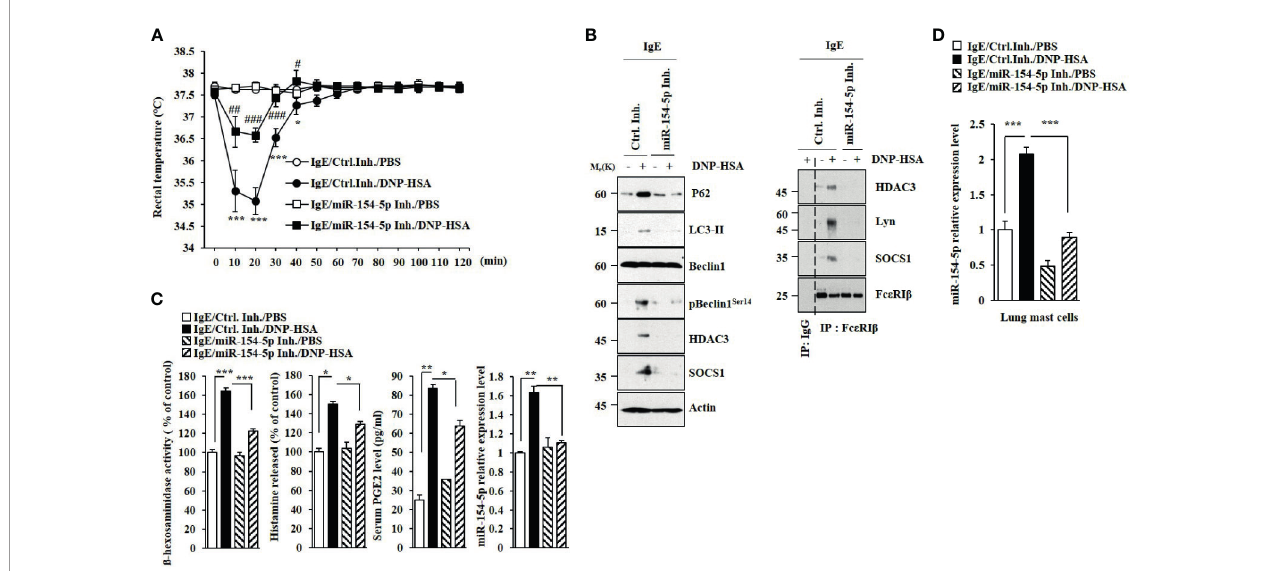
FIGURE 3 | MiR-154-5p mediates PSA. (A) BALB/C mice were intravenously injected with DNP-speci fi c IgE along with the indicated inhibitor (3.5 m g/kg). The following day, BALB/C mice were intravenously injected with DNP-HSA (250 m g/kg). Rectal temperatures were then measured. Each experimental group consisted of fi ve mice. Means ± S.E. of three independent experiments are depicted. * p <0.01, *** p <0.001 compared with IgE/miR-154-5p Inh./DNP-HSA. # p <0.05, ## p <0.01, ### p <0.001 compared with IgE/Ctrl. Inh./DNP-HSA. (B) Immunoblot and immunoprecipitation employing lung tissue were performed. Representative blots of three independent experiments are shown. (C) b -hexosaminidase activity assays, histamine release assays, and qRT-PCR were performed. Serum level of PGE2 was also determined. * p <0.05; ** p <0.01; *** p <0.001. Average values of three independent experiments are shown. (D) QRT-PCR of lung mast cell lysates was performed. *** p <0.001. Average values of three independent experiments are